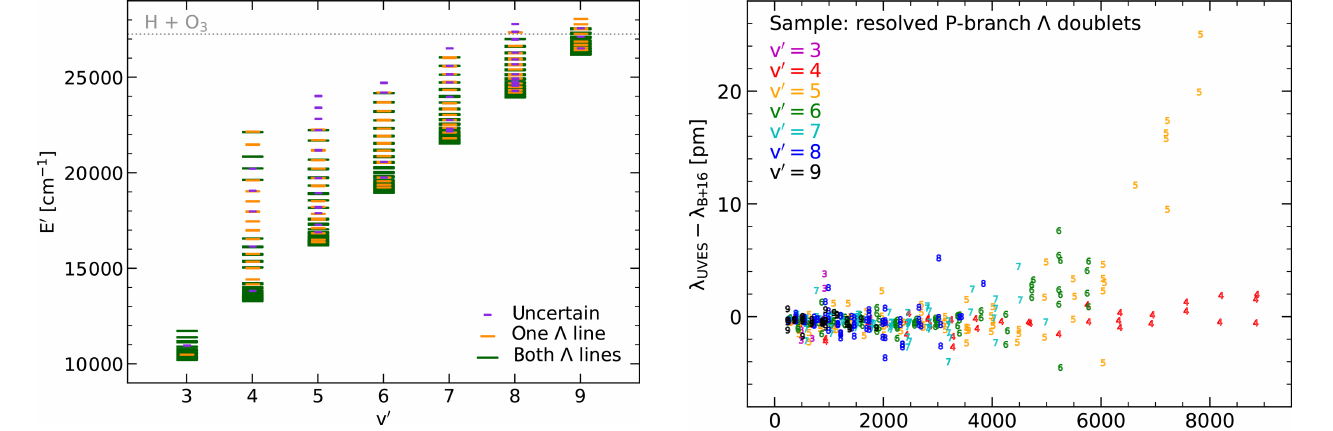
Figure 3. Distribution of the upper-level energies E (cid:48) of the mea- sured roto-vibrational transitions in inverse centimetres separated for each upper vibrational level v (cid:48) . The same categories as in Fig. 2 are marked by different colours and line lengths (see the legend). The likely exothermicity limit of the hydrogen–ozone reaction is marked by the grey dotted line.